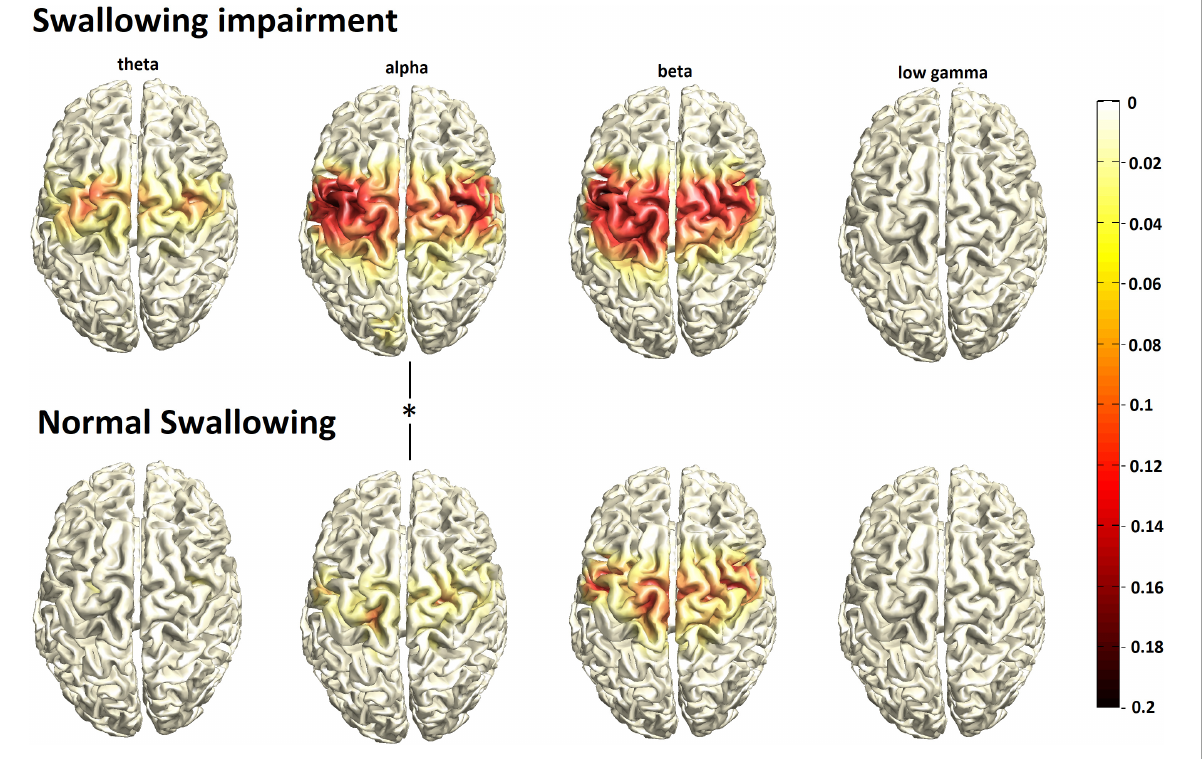
FIGURE1 Group mean swallowing associated cortical activation (N = 30/group) in participants with swallowing alterations (top row) vs. normal swallowing function (bottom row). The color bar represents power changes relative to the resting state, the asterisk indicates statistical significant